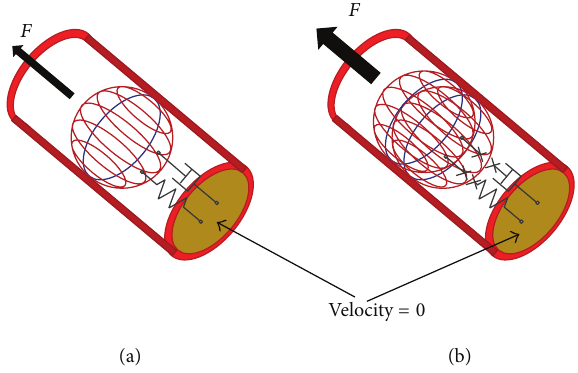
Figure 3: Spring-damper system. (a) 𝐹 < 0.01 N. (b) 𝐹 ≥ 0.01